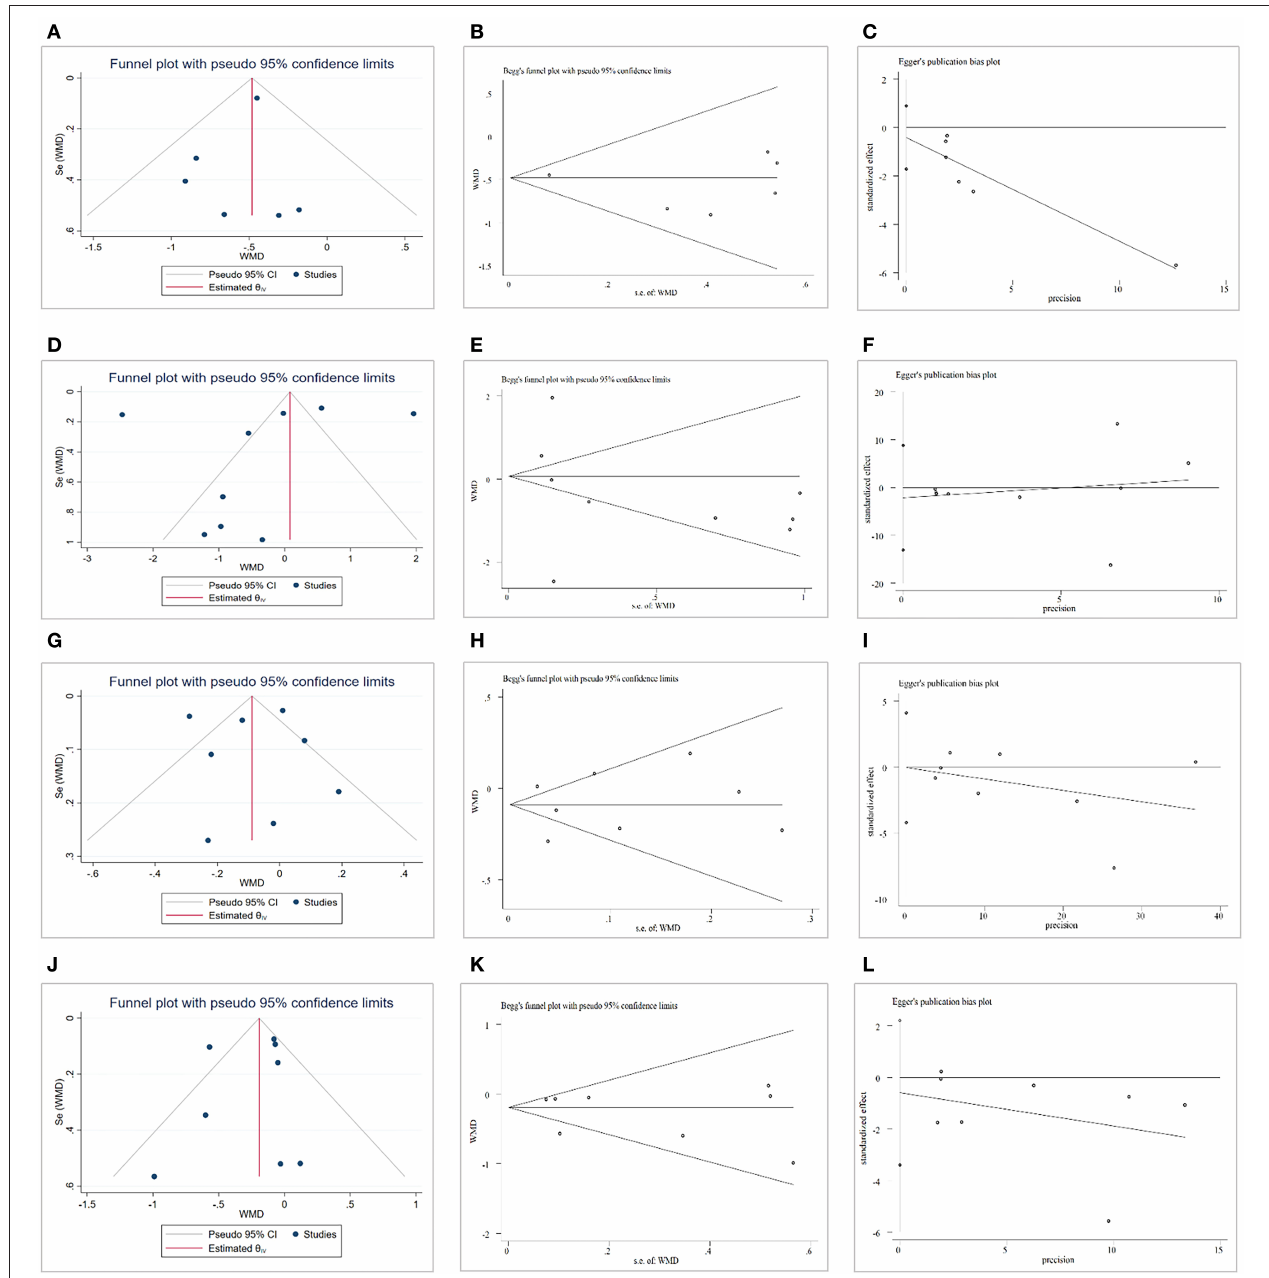
FIGURE 6 | Publication bias. (A) Funnel plot for total cholesterol (TC). (B) Begg’ test for TC. (C) Egger test for TC. (D) Funnel plot for triglycerides (TG). (E) Begg’ test for TG. (F) Egger test for TG. (G) Funnel plot for high-density lipoprotein cholesterol (HDL-C). (H) Begg’ test for HDL-C. (I) Egger test for HDL-C. (J) Funnel plot for low-density lipoprotein cholesterol (LDL-C). (K) Begg’ test for LDL-C. (L) Egger test for